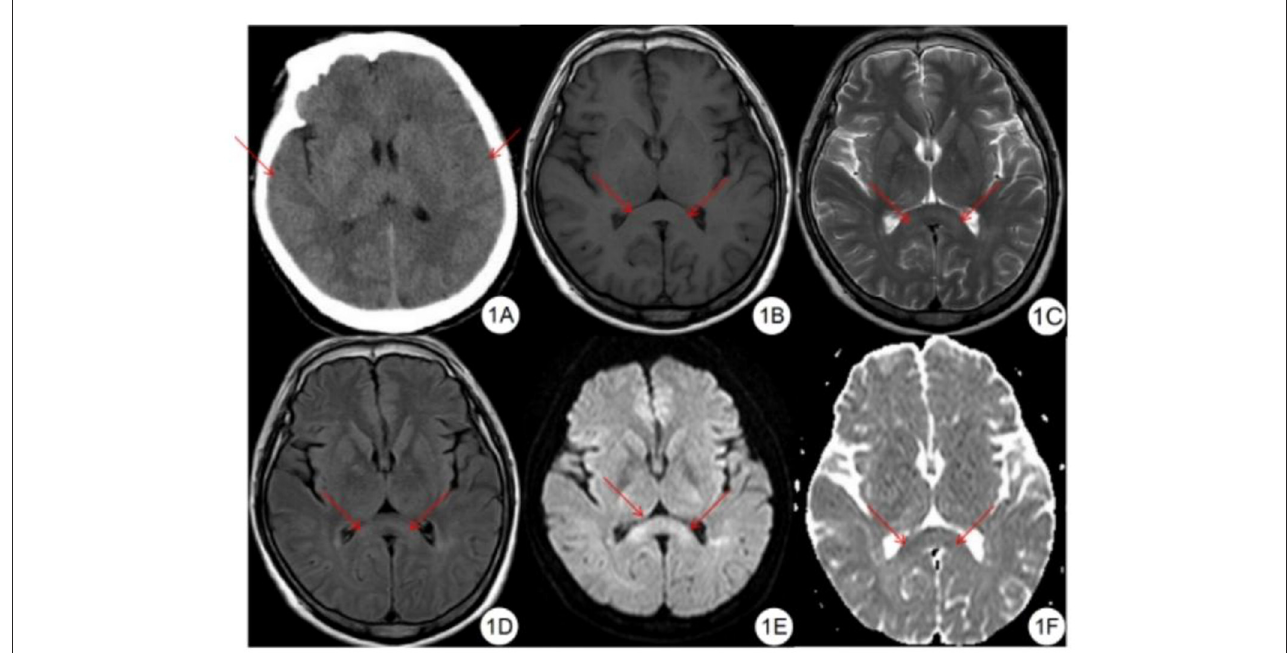
FIGURE1 Mild HACE patient. (A) CT plain scan showed that the sulcus and cerebral fissure were slightly shallower. (B) T1WI showed symmetrical slightly hypointensity in the splenium of the corpus callosum. (C) T2WI showed symmetrical slightly hyperintensity in the splenium of the corpus callosum. (D) FLAIR showed symmetrical slightly hyperintensity in the splenium of the corpus callosum. (E) DWI showed symmetrical hyperintensity in the splenium of the corpus callosum. (F) ADC shows symmetrical hypointensity in the splenium of the corpus callosum.